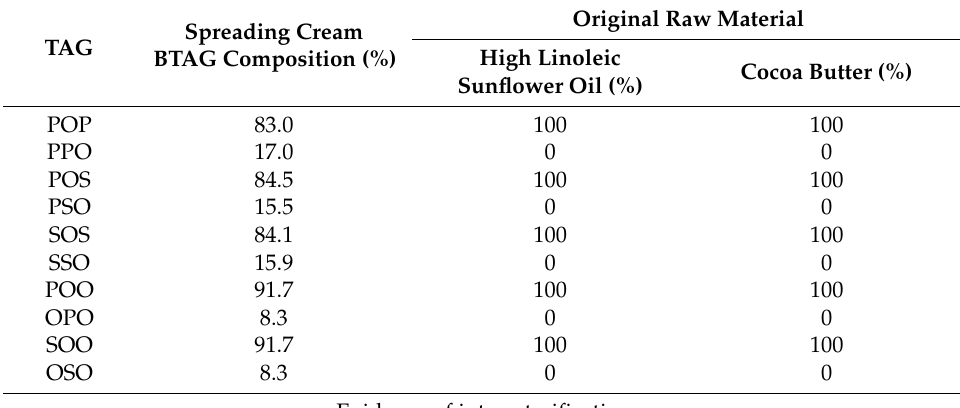
Table 4. Comparison of TAG percent composition between original raw materials and confectionery final products (spreading cream